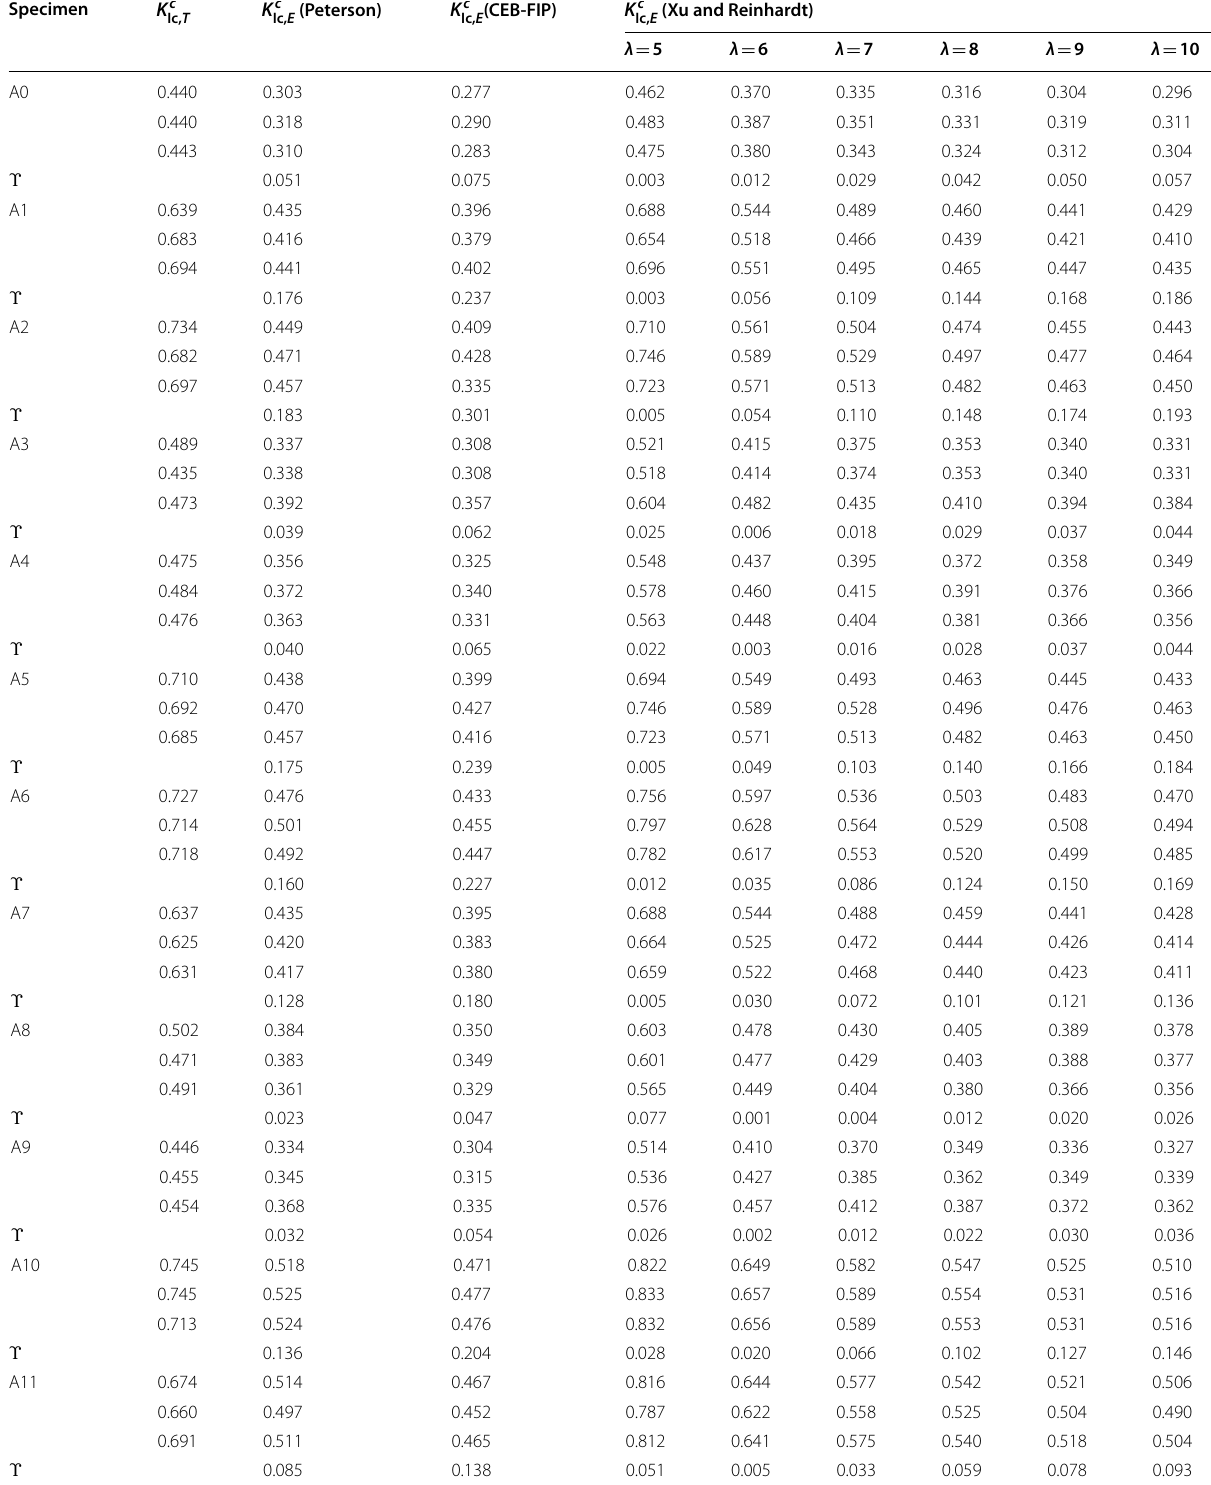
Table 4 Comparison of K C IC, T and K C IC, E (MPa m 1/2 ).